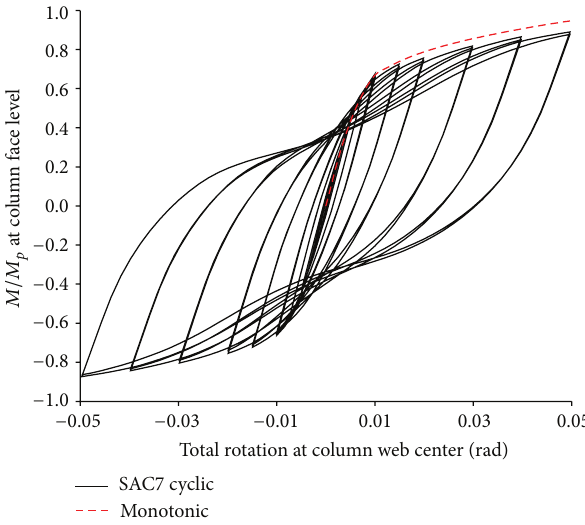
Figure 16: Normalized moment rotation curve of specimen SAC3 for 𝛼 = 2 , 𝛽 = 0.75 , and 𝛾 = 0.1